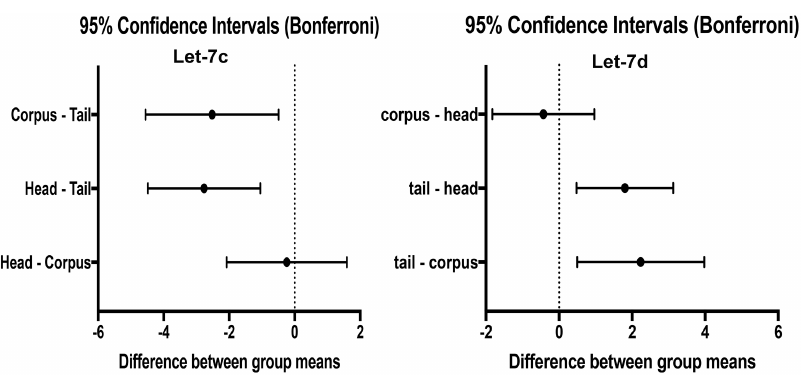
Figure 2. Serum miRNA let-7c and let-7d levels according to pancreatic cancer anatomic region of origin.